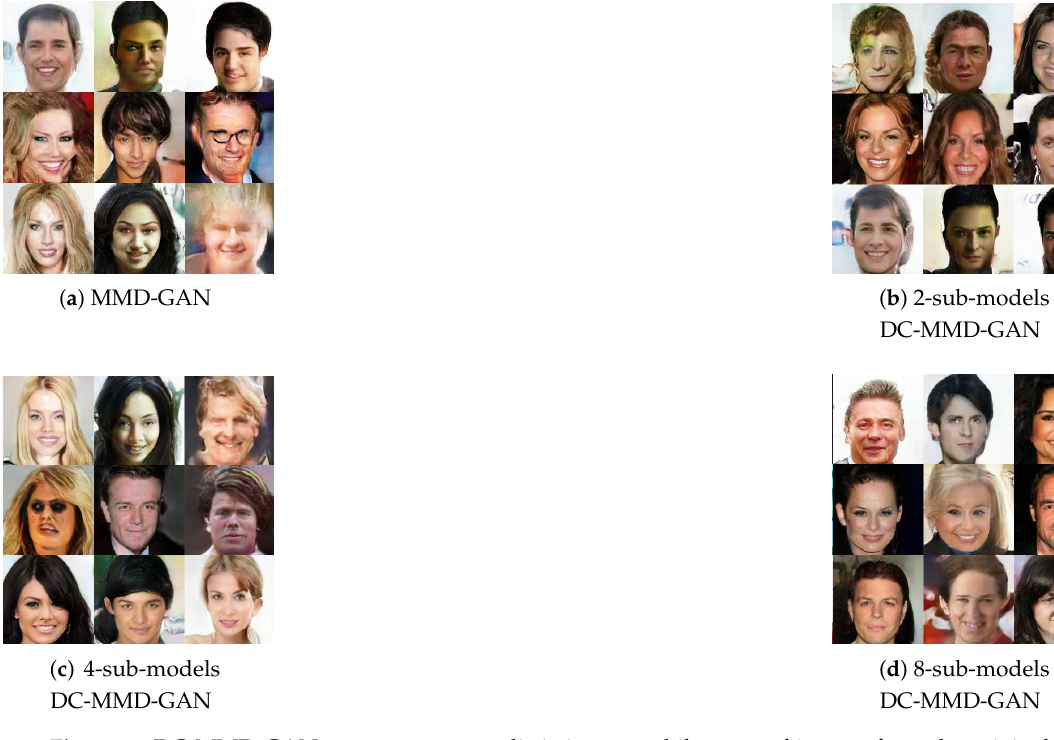
Figure 6. DC-MMD-GAN generate more realistic images while parts of images from the original models are